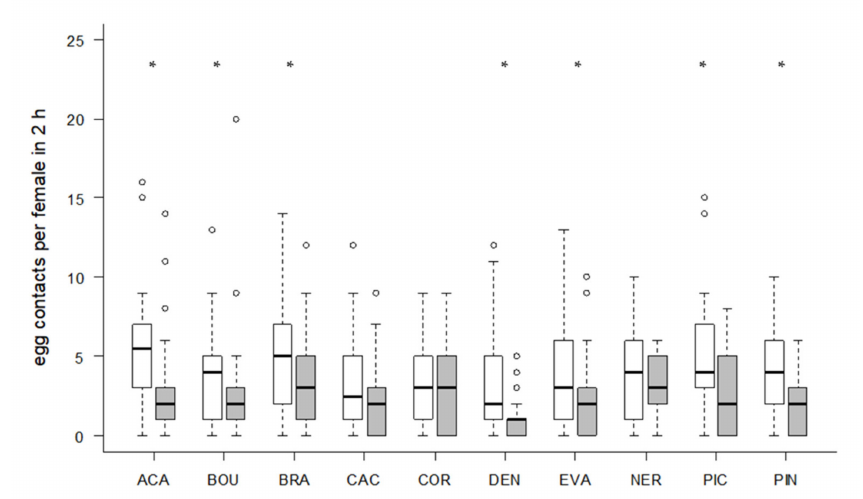
Figure 4. Number of contacts per parasitoid female with S. cerealella (white) and T. absoluta (grey) eggs in 2 h (24 observations / female in total). Box plots denote median (solid line), whiskers show range of data, and circles represent outliers. Asterisks indicate significant di ff erences within one Trichogramma strain ( p < 0.05, n = 30 females per strain).